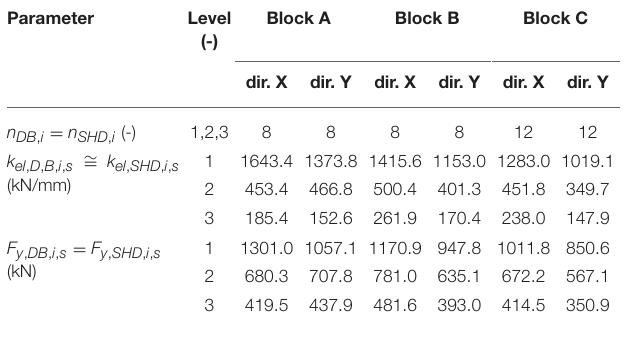
TABLE 6 | Design parameters of the DB units. Parameter Level Block A Block B Block C (-)